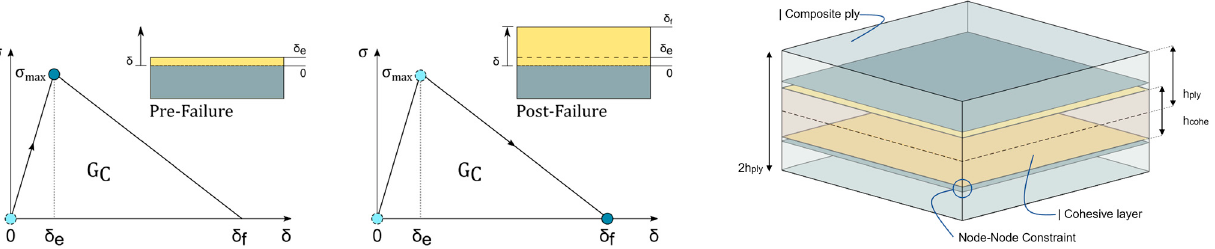
Figure 4. Cohesive constitutive law—bilinear shape; schematic shell-cohesive modeling technique representation with the definition of constitutive top and bottom surface of adjacent shell layers. Table 4. MAT138 material parameters for the interlaminar region of T800/F3900, as published in [40]. Variable